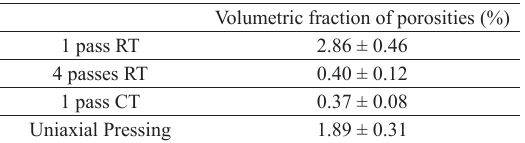
Table 1. Calculated volumetric fraction of porosities for different